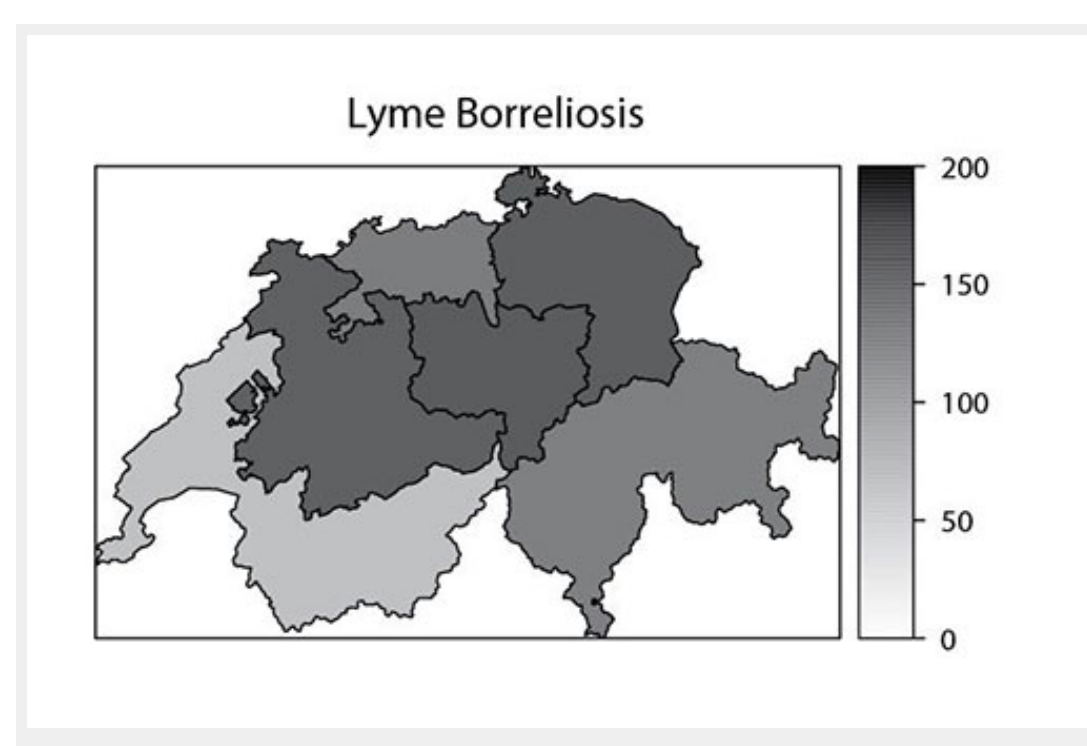
Figure 1 Geographic distribution by Sentinella Regions regarding treated tick bites, Lyme borreliosis and tick borne encephalitis, Switzerland 2008 to 2011.Panel 2: Lyme borreliosis, yearly incidence per 100,000 inhabitants, 2008–2011. Panel 3: Tick borne encephalitis, yearly incidence per 100,000 inhabitants,